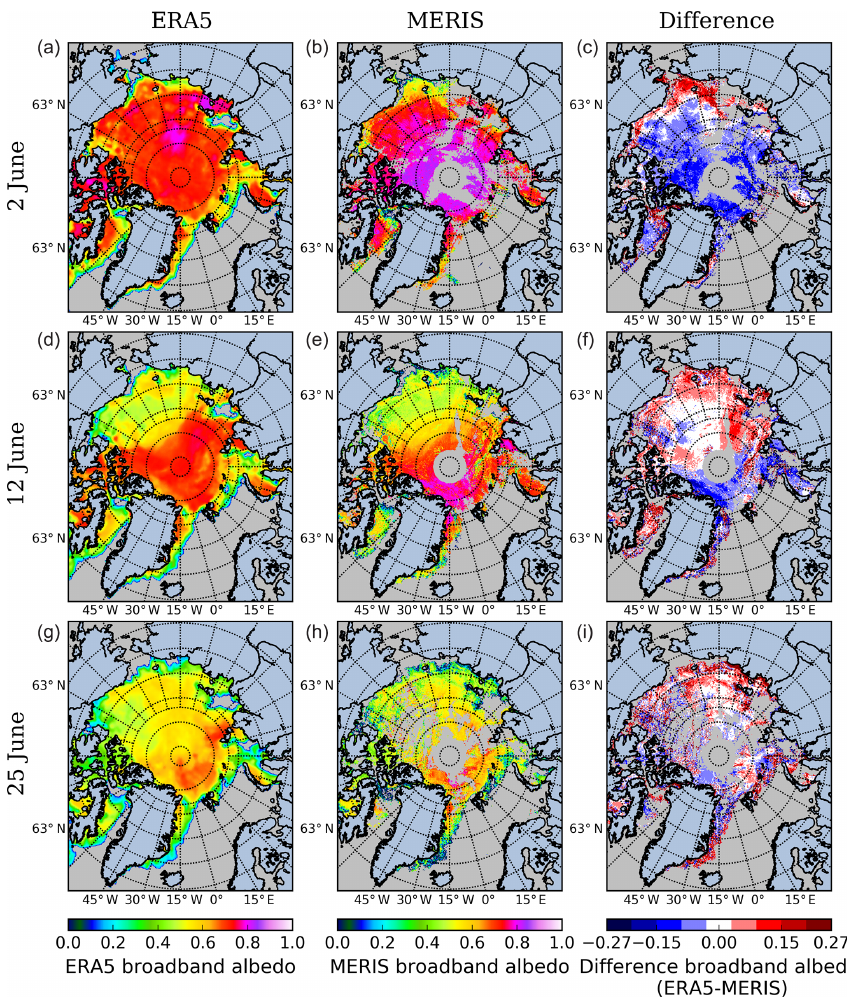
Figure 6. Daily averaged grid cell broadband albedo of Arctic sea ice derived from ERA5 irradiances (a, d, g) and MERIS observations (b, e, h) and the difference between both albedo products (c, f, i) . The data are from 2 ( a–c , before melt onset), 12 ( d–f , at melt onset), and 25 ( g–i , after melt onset) June 2007. Cloud-contaminated areas and the satellite pole hole in the MERIS data set are shown in gray. Data are gridded using the NSIDC (National Snow and Ice Data Center) polar stereographic